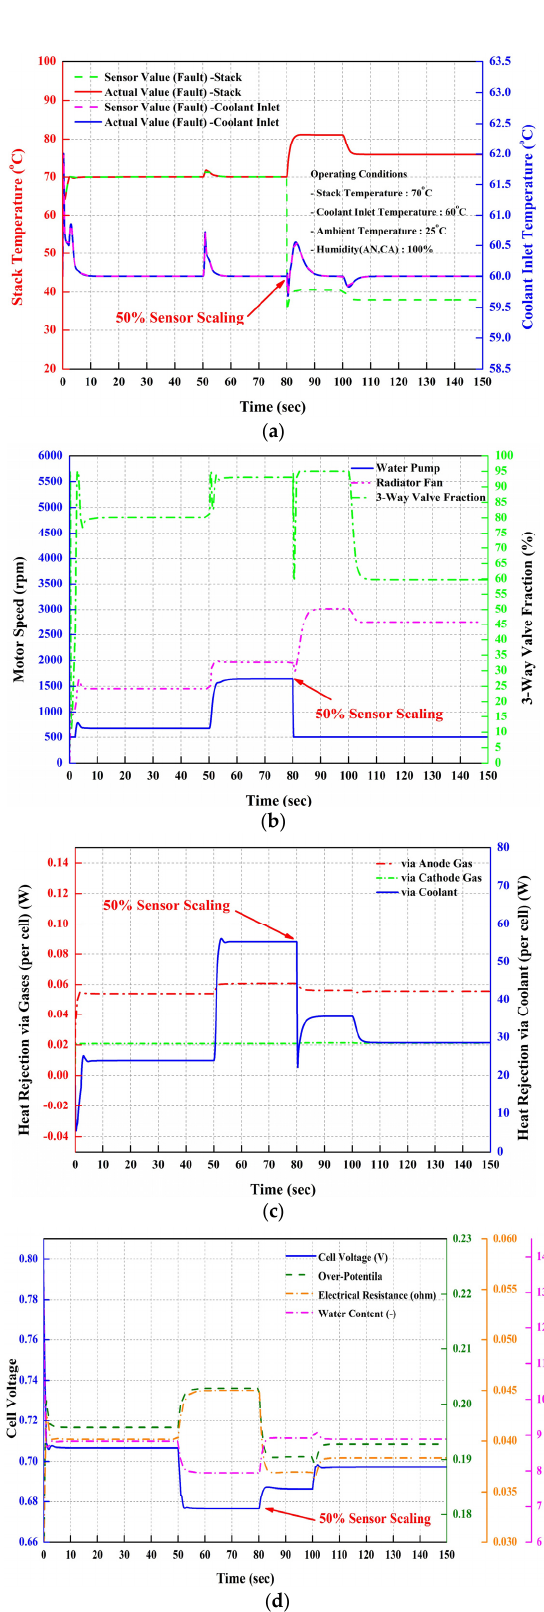
Figure 5. Transient sensor fault behavior in PEM fuel cell under sudden stack sensor scaling (( a ) Temperature of stack and coolant inlet, ( b ) cooling components, ( c ) heat rejection in stack, ( d ) voltage responses).